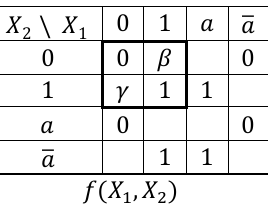
Figure 6. Function table for the function of example 1 with its Karnaugh map part